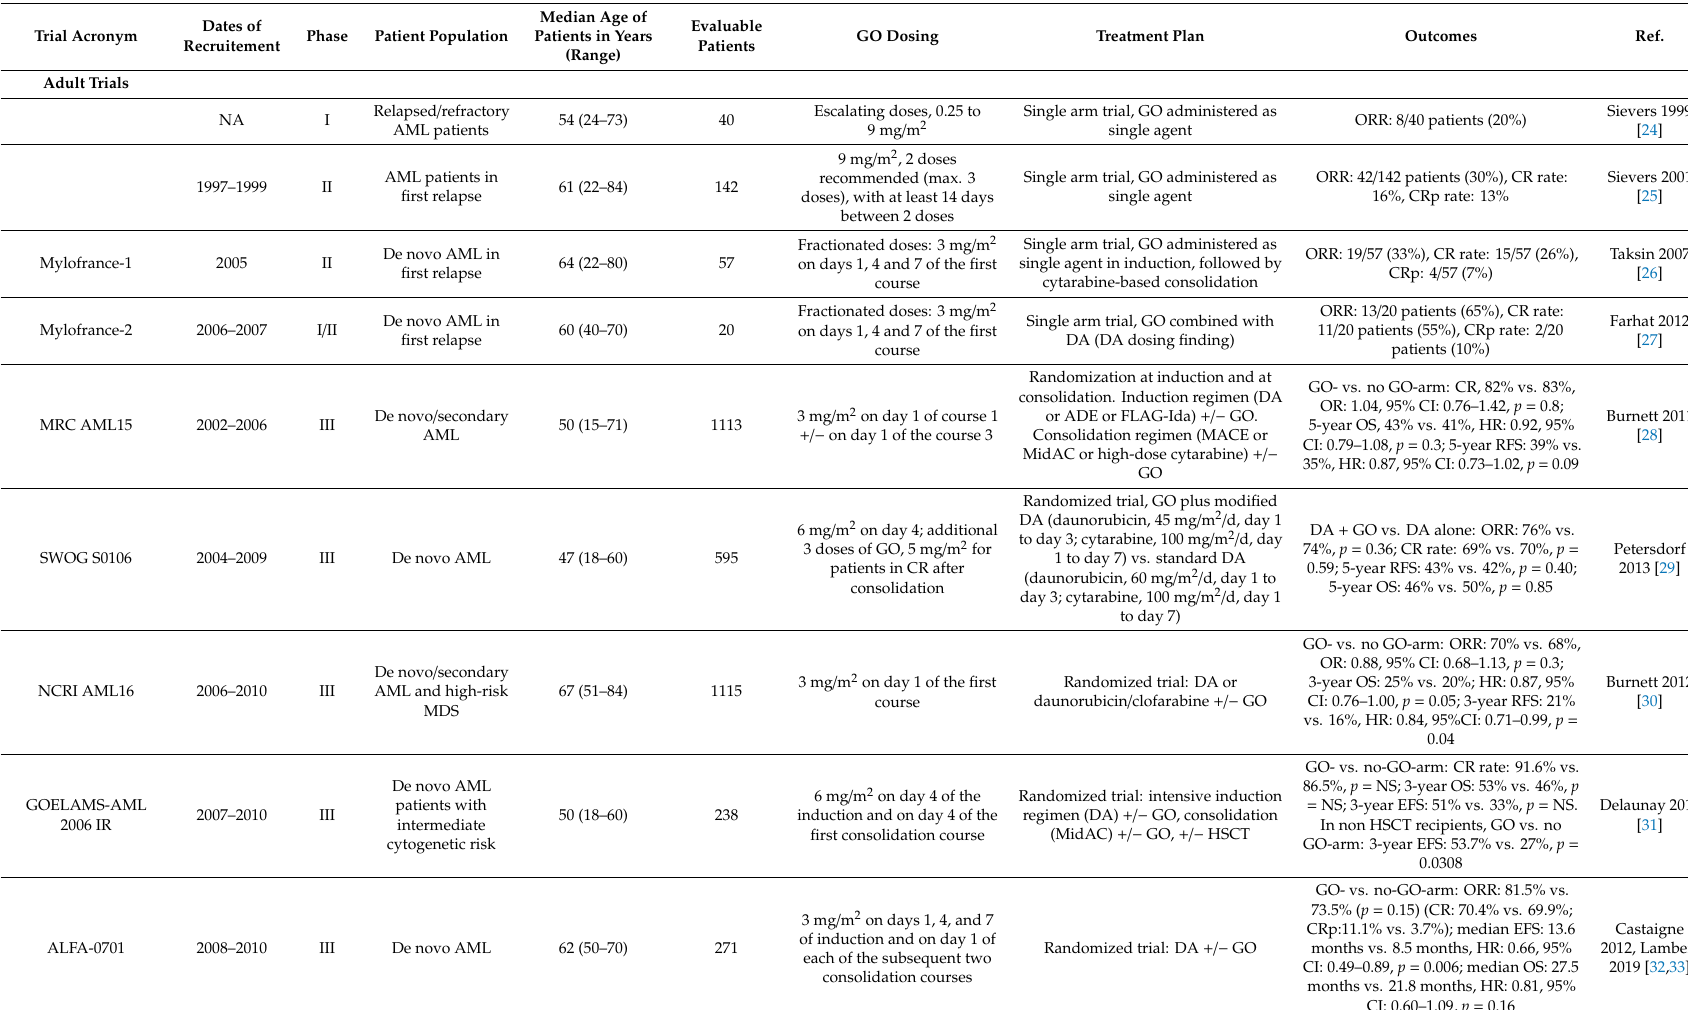
Table 1. Overview of the main clinical trials evaluating GO e ffi